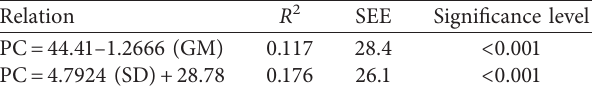
GM � grain moisture, PC � paddy crackness, SD � storage duration, SEE � standard error of the estimate, and R 2 � coefficient of determination.